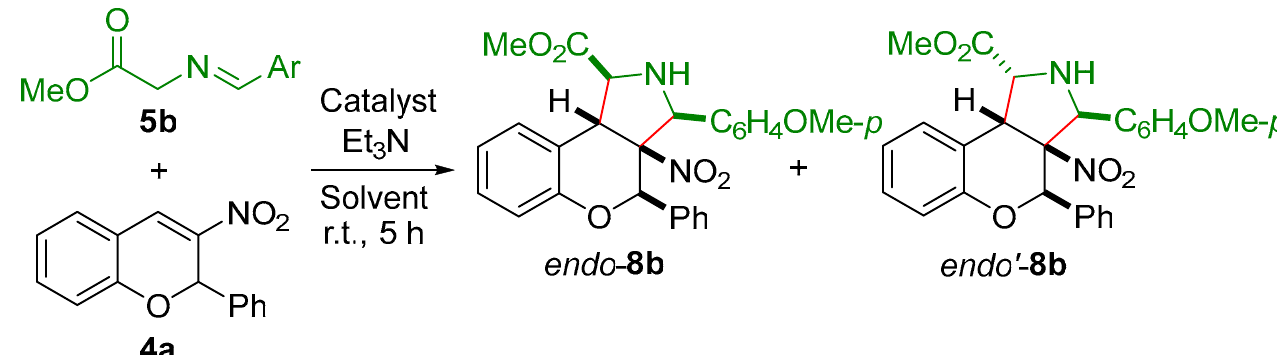
Scheme 3. The reaction of nitrochromene 4a with azomethine 5b . Table 1. Condition optimization for the reaction of 4a with 5b a . Table 1. Condition optimization for the reaction of 4a with 5b a .